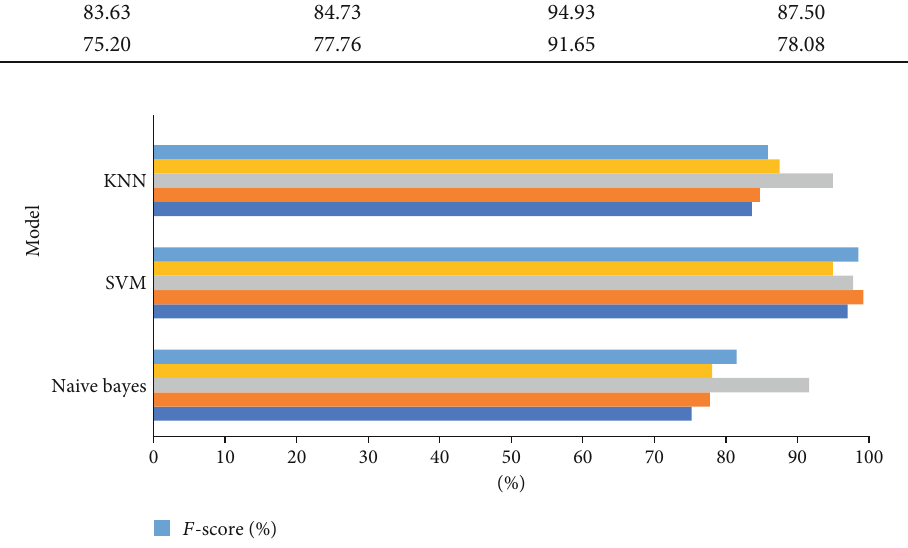
Figure 10: Performance of the machine learning algorithms used for the prediction of the WQC.